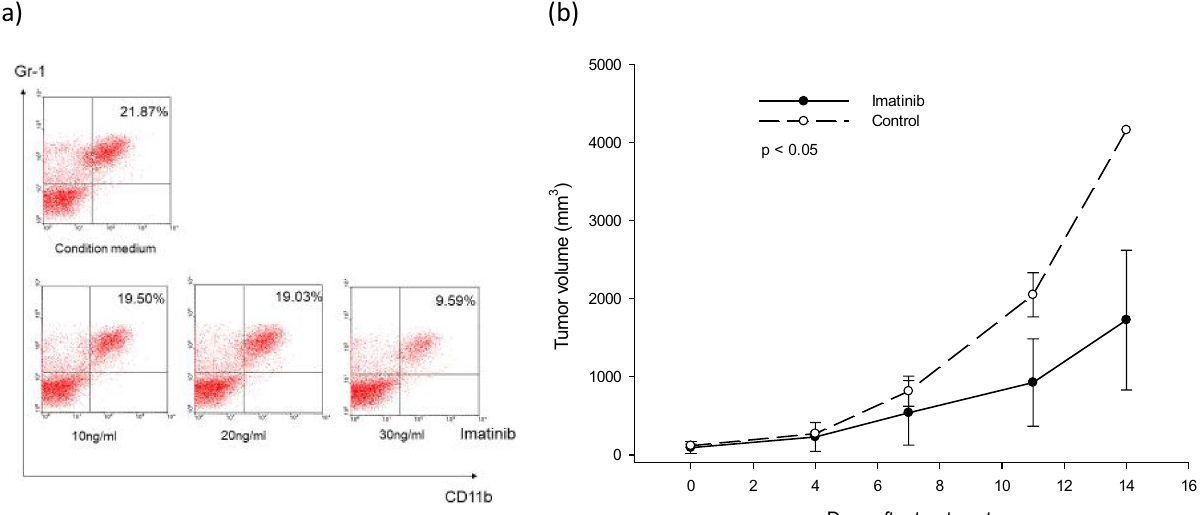
Figure 7. Representative decrease in the number of MDSCs by Imatinib. ( a ) The spleen cells harvested from B10 mice were maintained in conditioned medium for 7 days to expand Gr-1 + CD11b + cells. Different doses of Imatinib (10, 20, and 30 ng/ml) were added to block the effect of SCF. The frequency of Gr-1 + CD11b + cells was decreased when 30 ng/ml Imatinib was added. ( b ) When EL4 tumors on the back of B6 mice was 5 × 5 mm in diameter, the mice were treated with Imatinib. The tumor growth in Imatinib-treated mice was slower than in control mice. On day 11 of treatment, the tumor volume was 927.7 ± 558.5 mm 3 in the mice treated